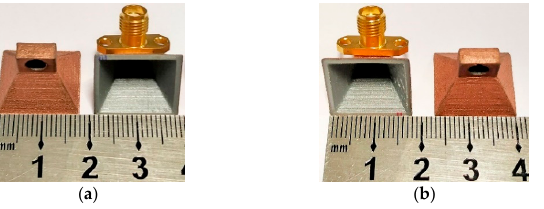
Figure 3. 3D-printed horn antennas with conductive paint: ( a ) without sanding process and ( b ) with sanding process.